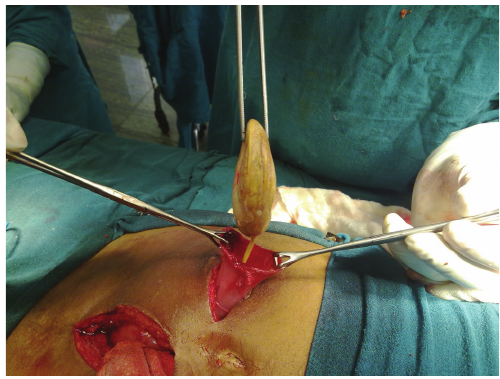
Figure 1: Intraoperative photographs.